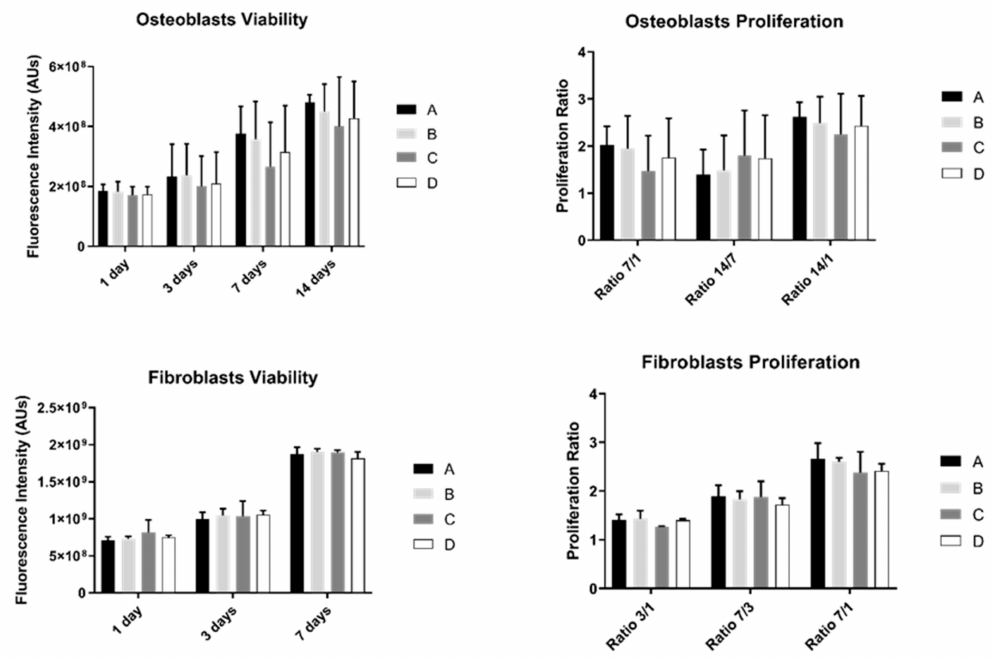
Figure 2. Graphs showing osteoblasts and fibroblasts’ viability as a mean of the registered fluores- cence intensity of resorufin expressed in arbitrary units (N = 15) for each study group (as described in Table 1). Error bars represent a standard deviation. A Kruskal–Wallis, followed by Dunn’s test, was used for comparisons between study groups. Statistical significance was defined as: p <